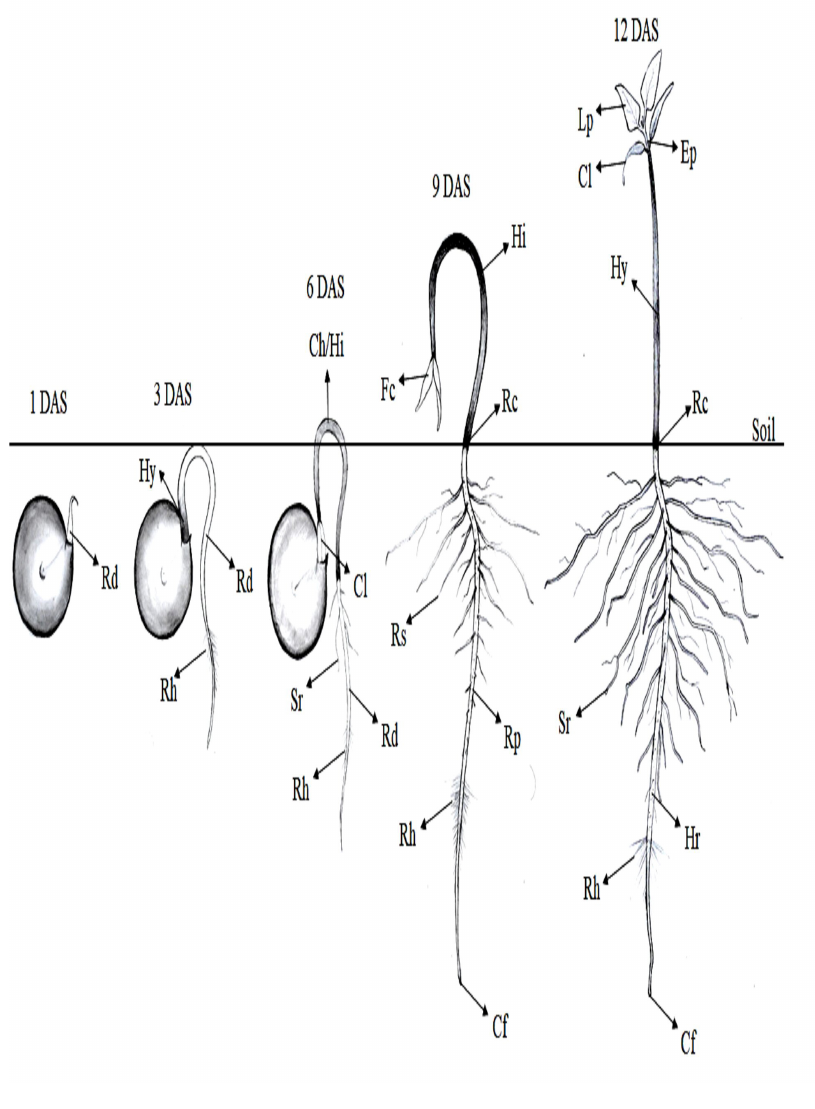
Figure 4. Morphological characterization of the emergence of quinoa